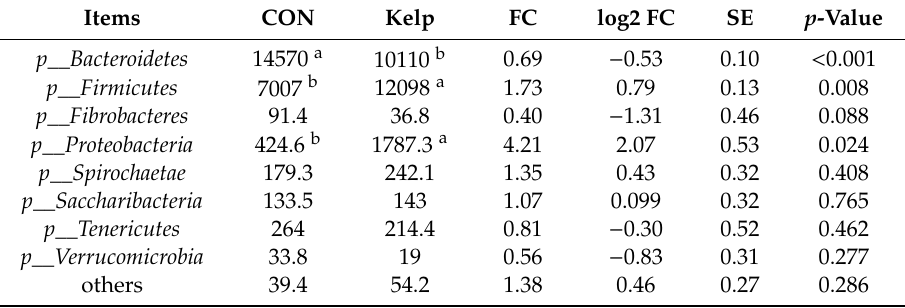
Table 4. E ff ects of kelp powder on the abundances of ruminal microbiota in phyla level.